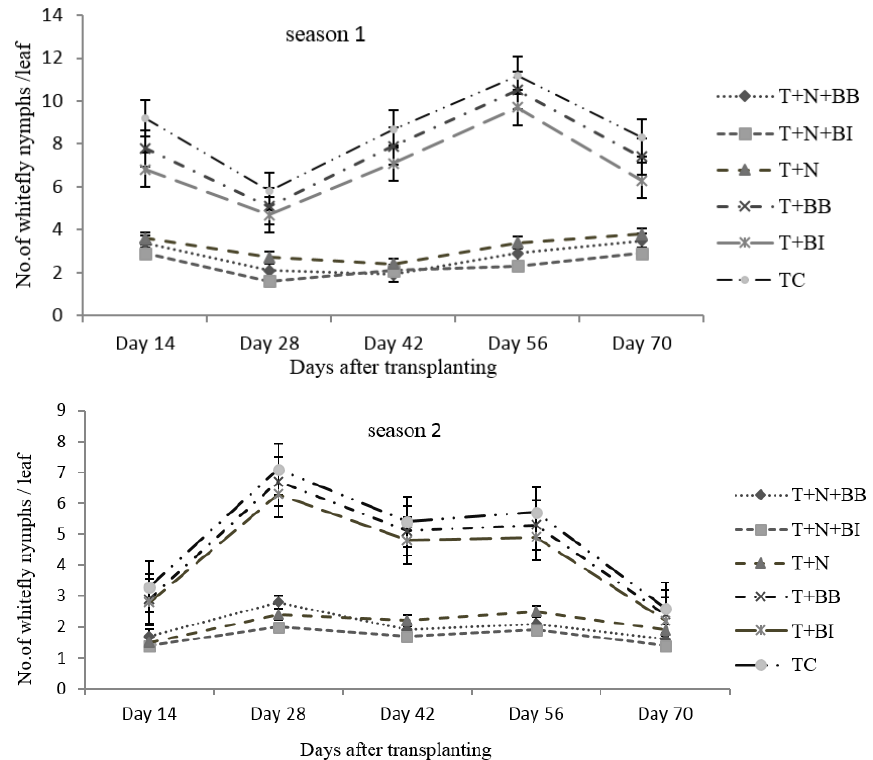
Figure 1. Effects of Agronet Cover and Companion Planting with Basil on Number of B. tabaci Nymphs on Tomato Plants (No./leaf)during Tomato Production in Season 1 (December 2013–April 2014) and Season 2 (May 2014–September 2014). Key: T + N + BB is tomato under agronet with abasil border surrounding outside of the net cover; T + N + BI is tomato under agronet with a basil row between adjacent rows of tomato; T + N is tomato under agronet without basil; T + BB is tomato without agronet cover with a basil row surrounding the outside of the agronet cover; T + BI is tomato without agronet cover with a basil row in between adjacent rows of tomato; and TC is tomato without agronet cover or basil (control).